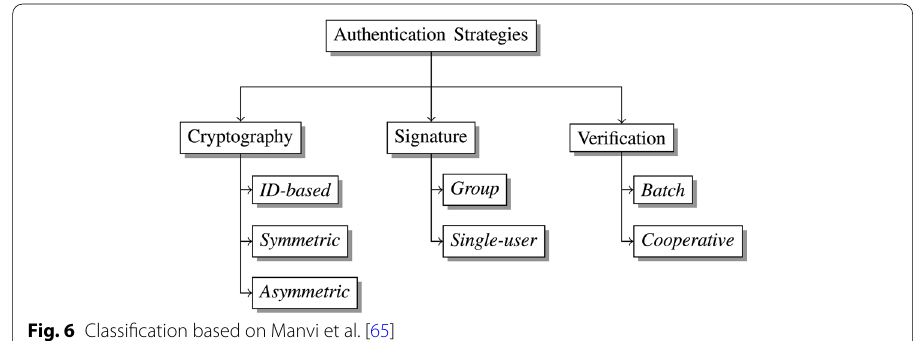
Fig. 6 Classification based on Manvi et al.